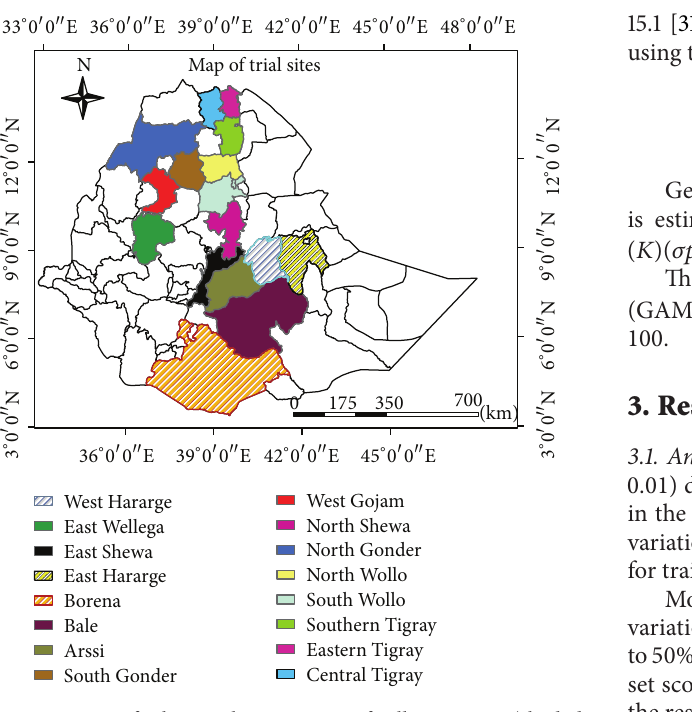
Figure 2: Map of Ethiopia showing areas of collection sites (shaded region) of the landrace